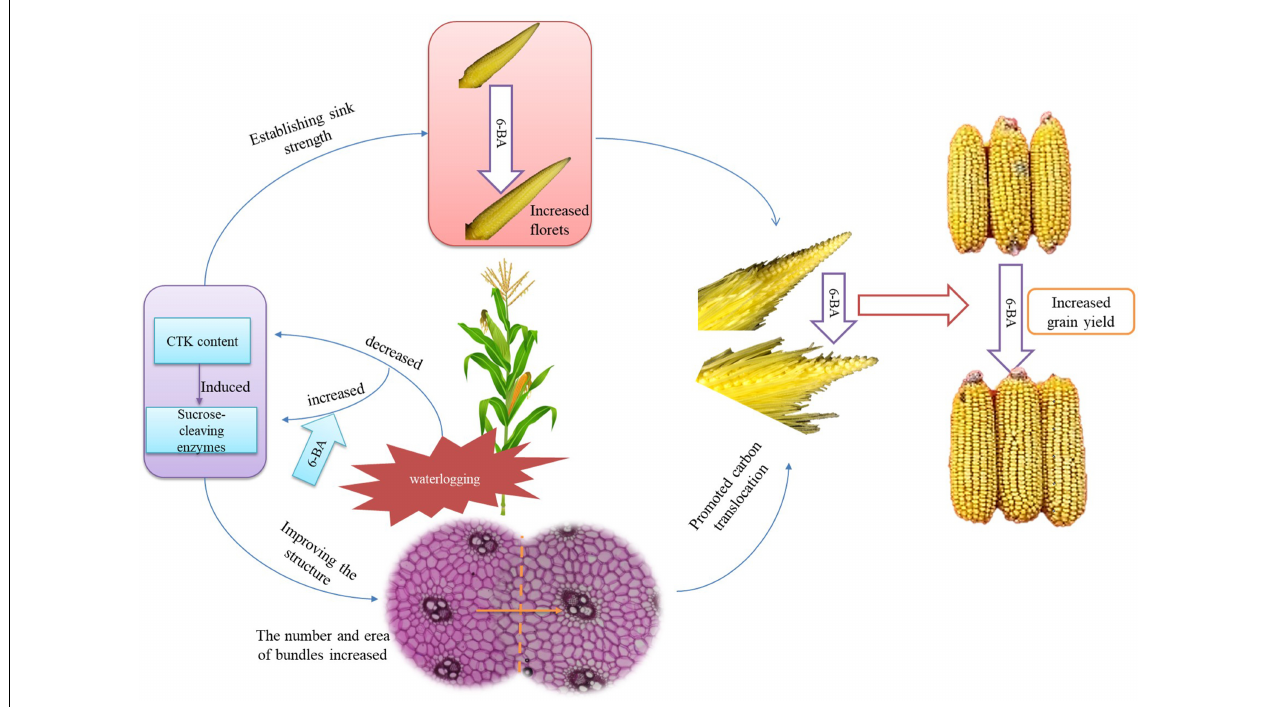
FIGURE 9 | The mechanism of 6-BA improving the grain yield of summer maize. The application of 6-BA significantly improved the hormone and sugar metabolism, thus establishing the sink strength and improving the spike node structure to promote carbon translocation. As a result, the number of florets was increased; the spikelets and florets were developed coordinately and synchronously, leading to a higher grain yield of waterlogged summer maize.